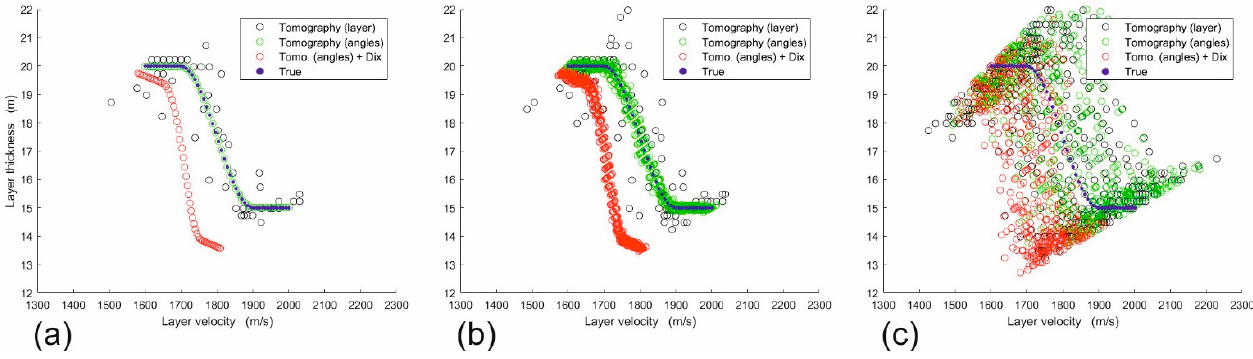
Figure 3. Inversion estimates for 50 traces using tomography for layer parameters (black circles), angles (green circles) and with a Dix post-processing (red circles). The true model values are indicated by blue dots. The results’ scattering depends a lot on the maximum error percentage in the travel times: none ( a ), 0.001% ( b ) and 0.01% ( c ).